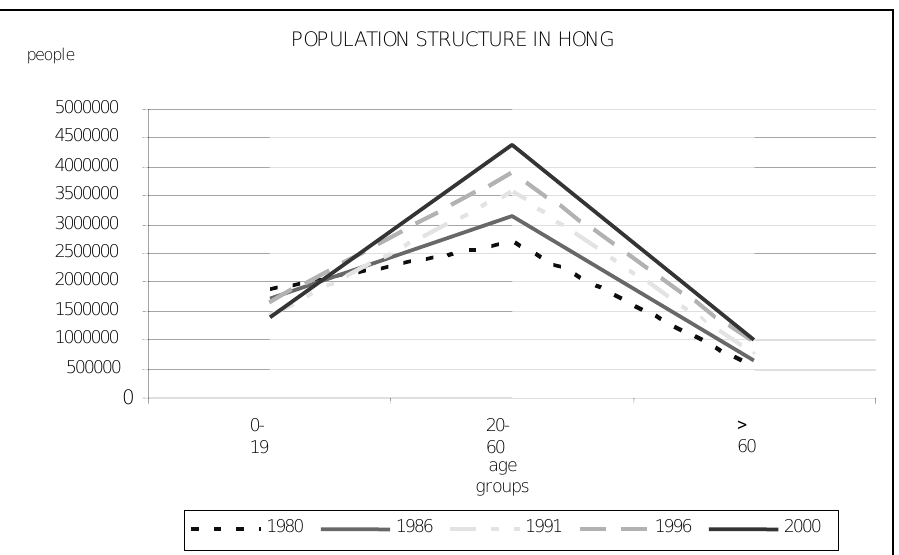
Figure 2: Population age composition in Hong Kong, 1980–2000 POPULATION STRUCTURE IN